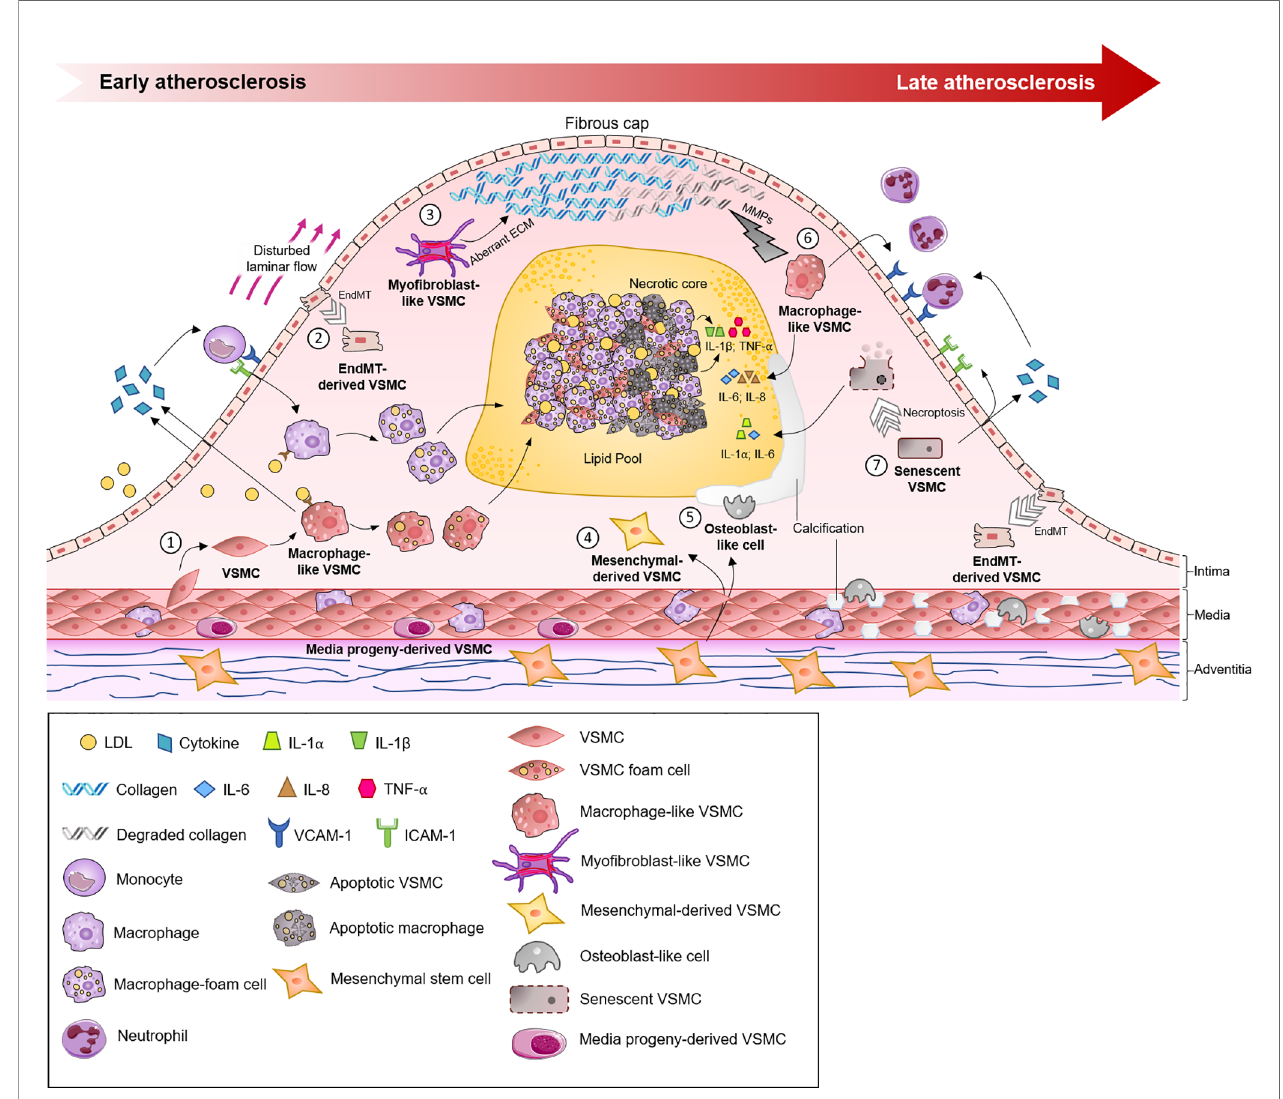
FIGURE 3 | Schematic representation of several processes mediated by myo fi broblast-like vascular smooth muscle cells (VSMCs) in atherosclerosis. Myo fi broblast- like VSMCs are responsible for the production of extracellular matrix components (type I and II collagen and fi bronectin) and in fl ammatory cytokines. Disequilibrium between MMPs/TIMPs results in selective ECM cleavage to expose bioactive molecular fragments and matrikines. Both matrikines and aberrant ECM further in fl uence the in fl ammatory response by modulating chemotaxis and activation of circulating immune-competent cells. In fi ltrating immune cells secrete cytokines, which further activate and promote phenotypic transition to myo fi broblast-like VSMCs. Aberrant ECM deposition in the fi brous cap and activated in fl ammatory cells increase the risk of plaque fi ssuring and subsequent rupture. ECM, extracellular matrix; MMP, matrix metalloproteinase; TIMP, tissue inhibitor of metalloproteinase; TLR, Toll-like receptor; VSMC, vascular smooth muscle